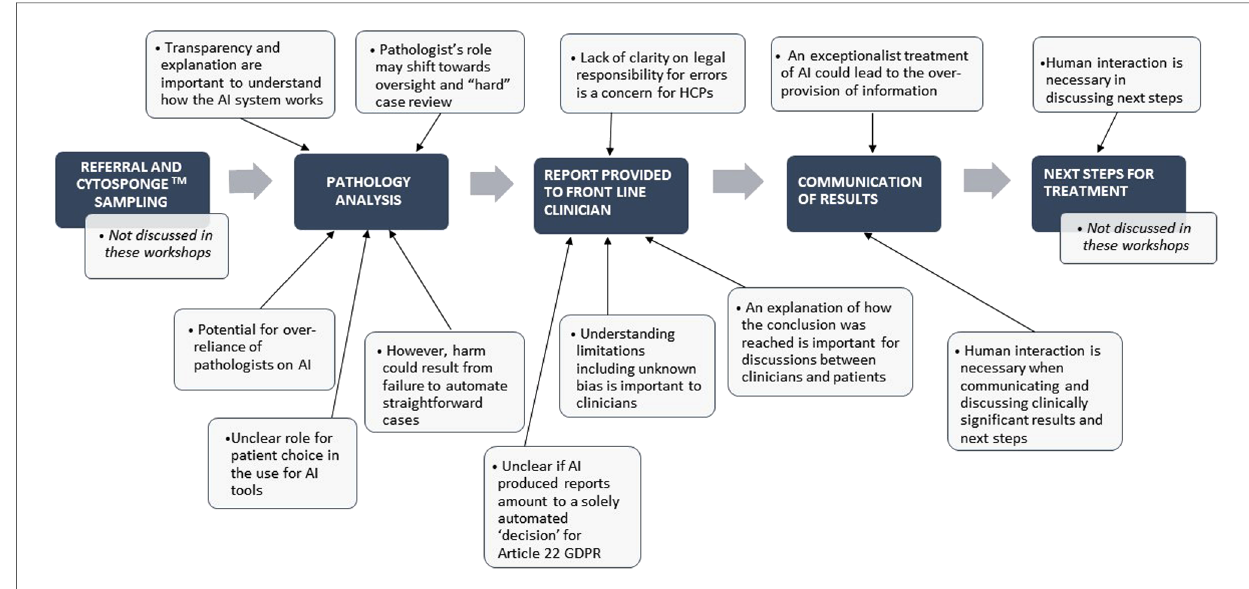
FIGURE 1 Key ethical and legal considerations in a diagnostic pathway incorporating AI